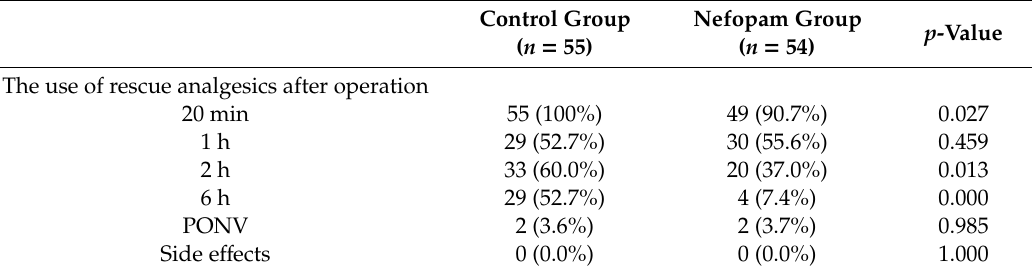
Table 3. The use of rescue analgesics and incidence of adverse